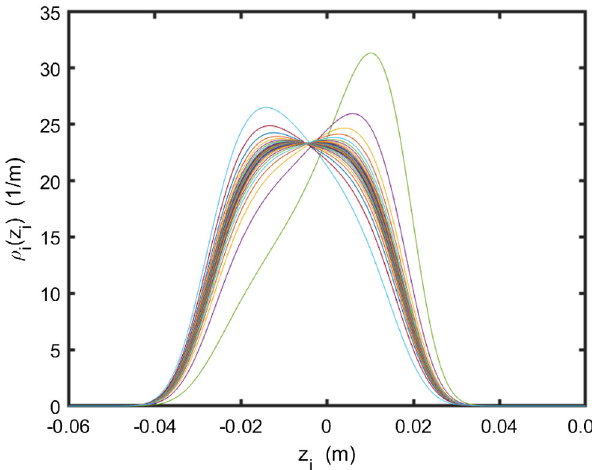
FIG. 9. Case of tapered bunch charges, MC beam loading ¼ 496 mA. included, I av